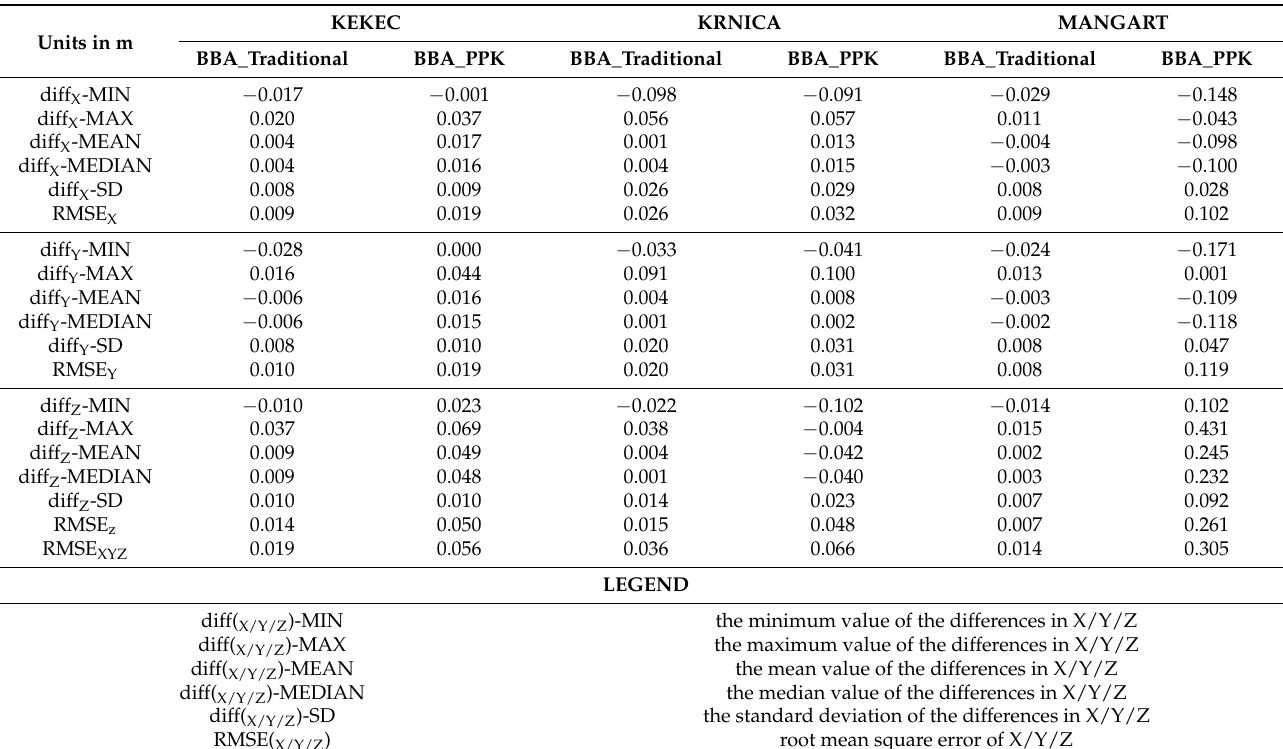
Table 3. Basic statistics for the differences in X, Y and Z coordinates of VPs measured in the field by total station and obtained by the BBA_traditional and BBA_PPK